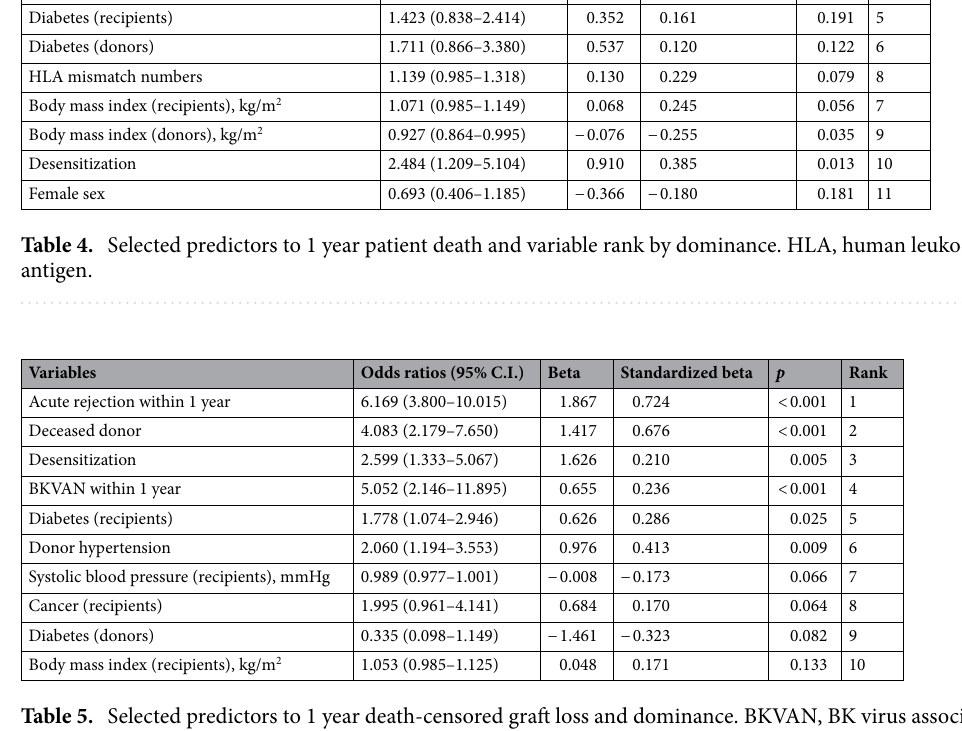
Table 5. Selected predictors to 1 year death-censored graft loss and dominance. BKVAN, BK virus associated nephropathy.